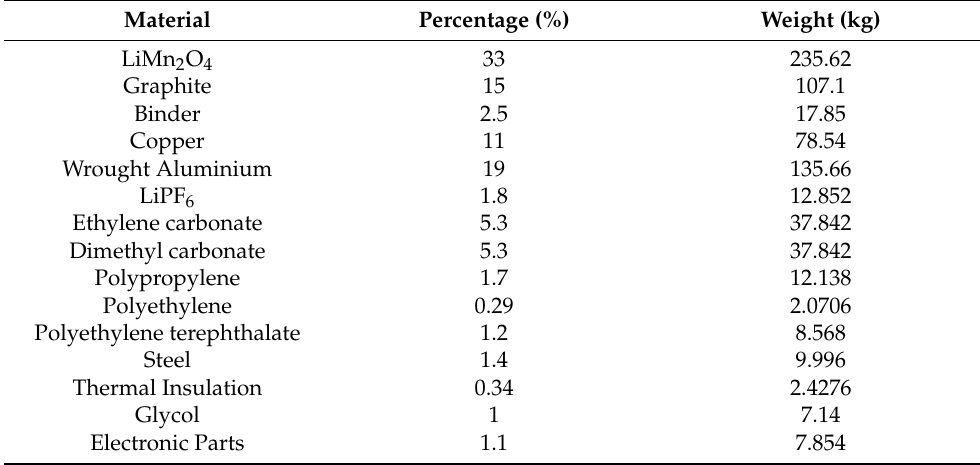
Table 3. Scaled BOM for FC